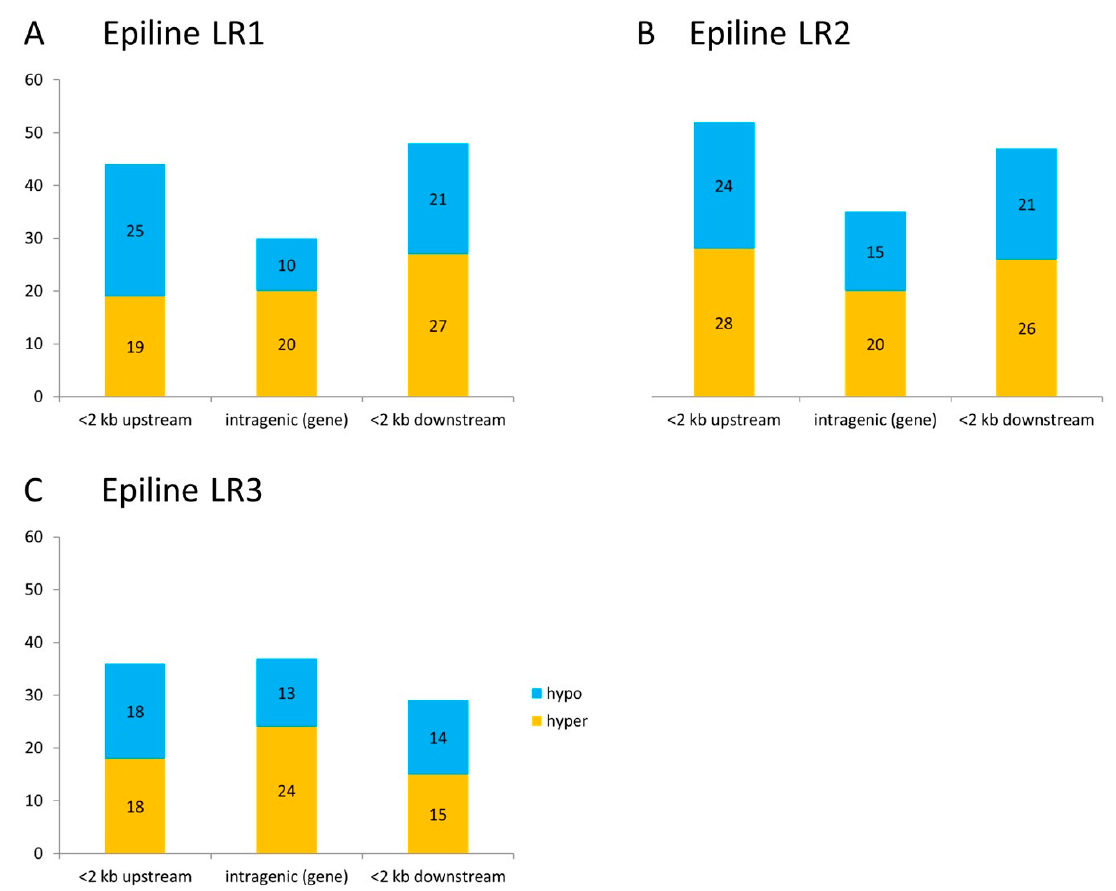
Figure 2. Gene ‐ associated location of stringently selected highly DMRs (hDMRs) that contain almost exclusively CG sites (CG ‐ hDMRs). For epiline LR1 ( A ), LR2 ( B ), and LR3 ( C ), the locations of hyper ‐ /hypo ‐ methylated hDMRs are shown within 2.0 kb upstream of genes, within genes, and a maximum of 2.0 kb downstream of genes using the reference genome annotation of Oryza sativa ssp. indica ([30], PLAZA 9311_BGF_2005).